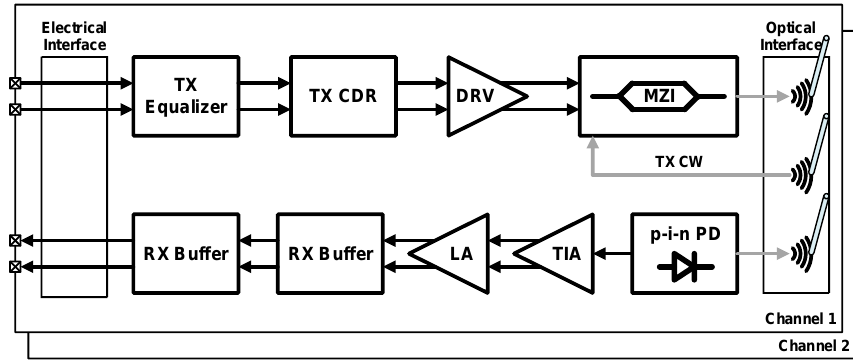
Figure 6. 2 × 10-Gb/s dual channel optoelectronic transceiver [44].